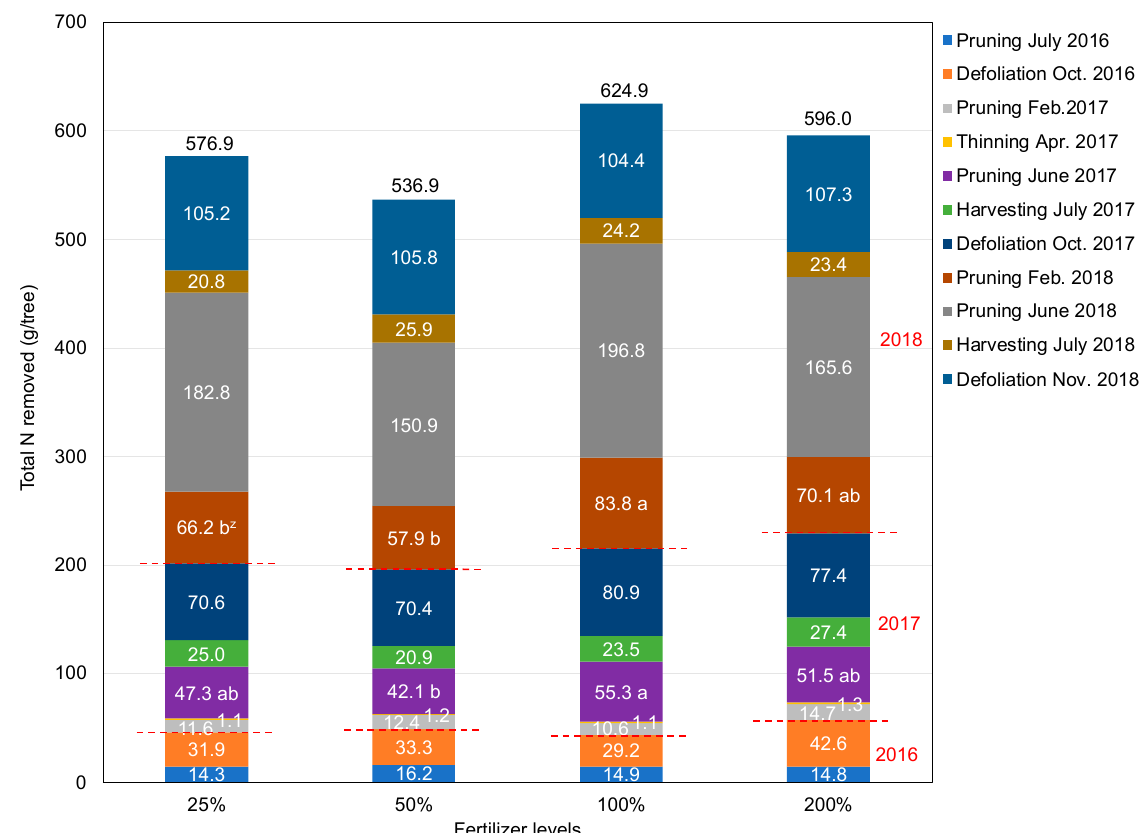
Figure 4. Total N removed per tree for the different fertilizer levels (25, 50, 100, and 200%) of the “Julyprince” peaches in 2016, 2017, and 2018. For each removal event (different colors), the means are shown inside the bars. z Means followed by a different letter within a removal event are significantly different by Tukey’s honestly significant different test, P ≤ 0.05. Means without letters indicate non-statistical differences, P > 0.05.